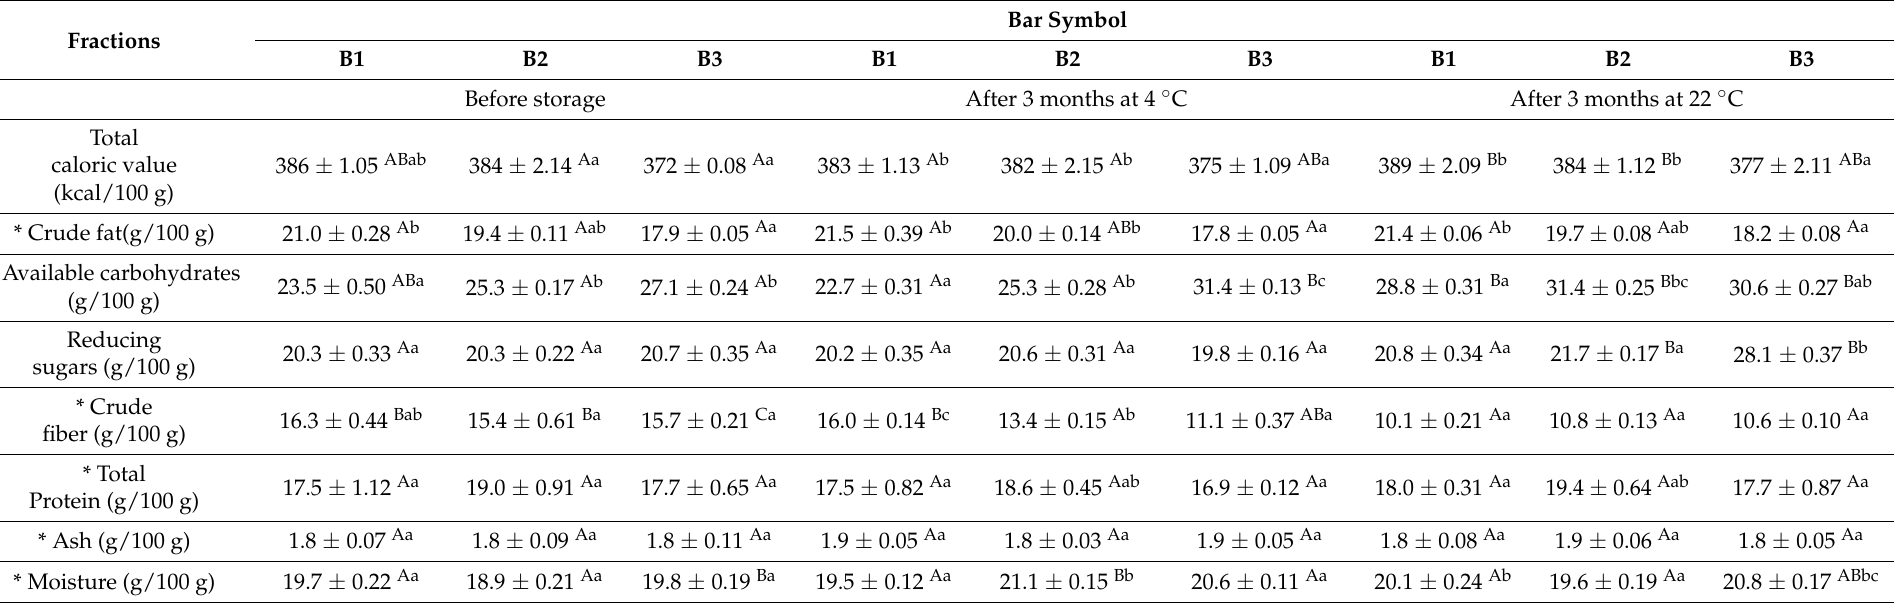
Table 2. Proximate chemical composition of organic protein bars during